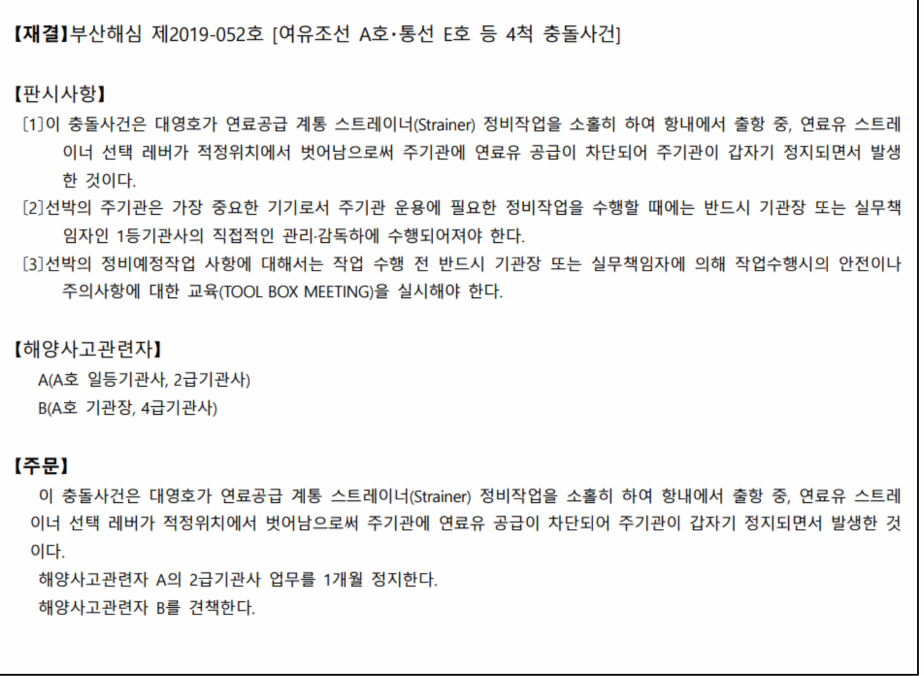
Figure 2. Sample maritime accident